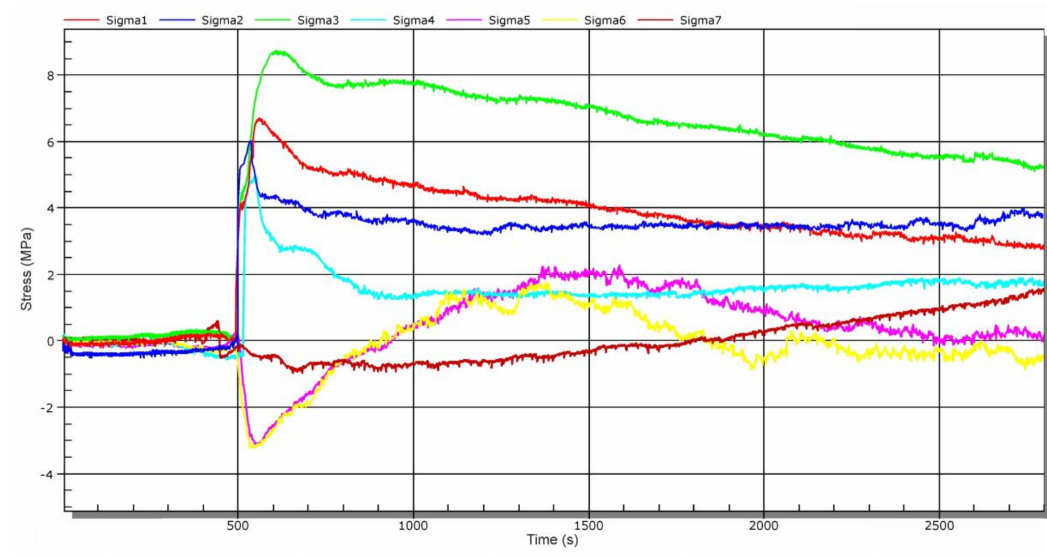
Figure 13. Time-dependent stress chart during sluice gate lowering—stage 2.